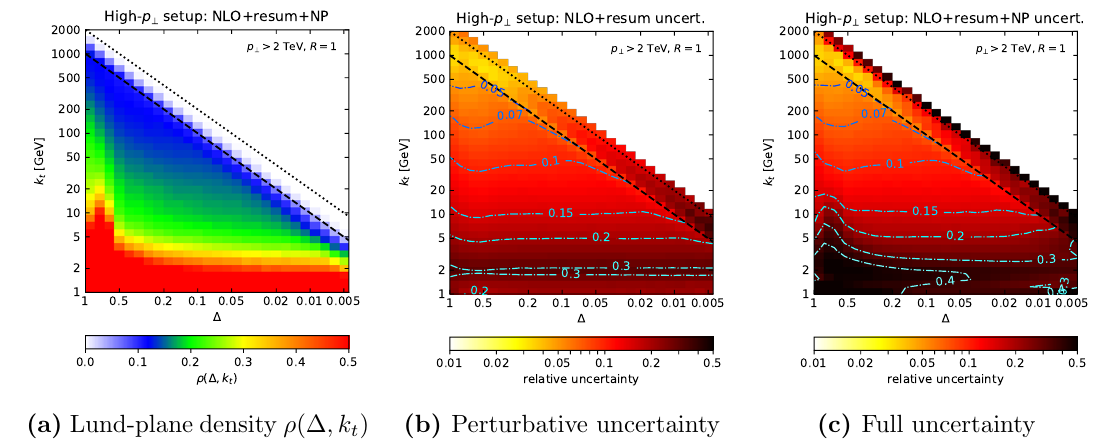
Figure 10. Predictions for the primary Lund plane density for the high- p ? setup (a) and as- sociated perturbative (b) and full (c) uncertainties. Full uncertainties sum the perturbative and non-perturbative contributions in quadrature.